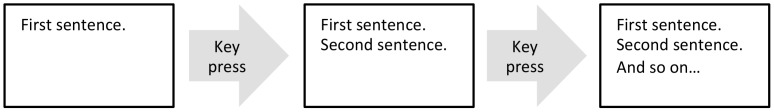
Illustration of the reading task with sentence units.Participants revealed each new text unit by pressing a space bar. Text would build up on the screen, line by line, until the whole screen was filled with text. When the whole screen was filled with text and the participant hit space once more, the screen would blank and the next text unit (word, phrase, or sentence) would appear in the upper-left corner.